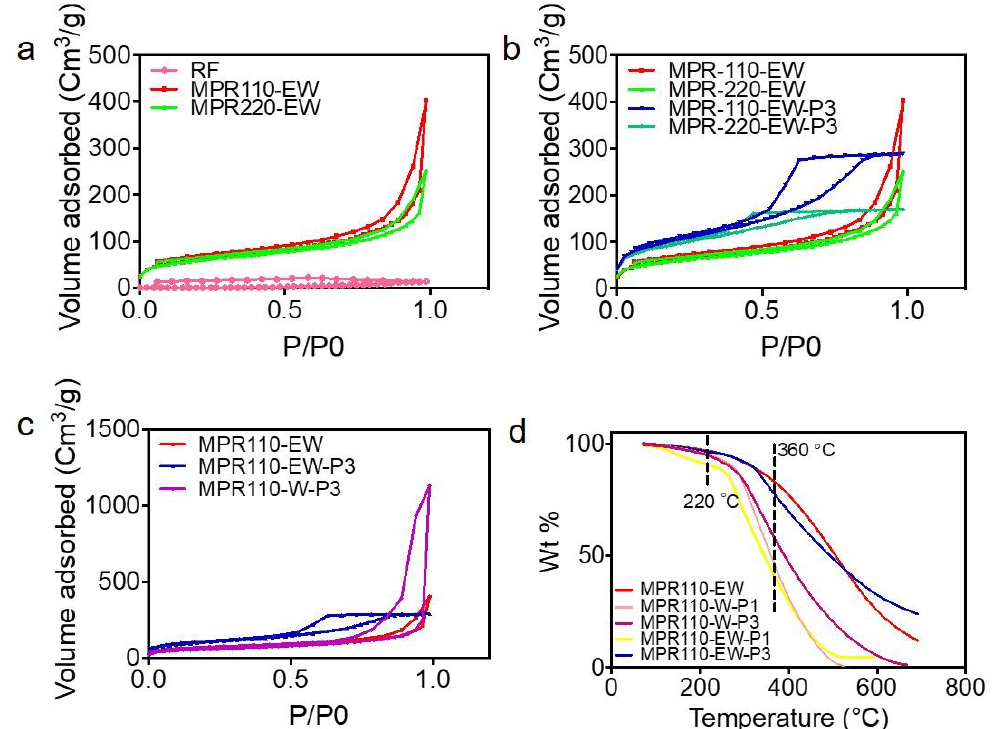
Figure 1. ( a – c ) N 2 adsorption − desorption isotherms of ( a ) MPR with varying PEI concentration, ( b ) Pd-MPRs with varying Pd concentrations, and ( c ) Pd-MPRs made either in the presence of water or water / ethanol as the solvent. ( d ) Thermal stability of MPR with varying PEI concentration (RF = nonporous resorcinol-formaldehyde resin; 110 and 220 = 110 mg and 220 mg PEI, respectively; EW = ethanol-water; W = water solvent; P1 and P3 = 1 wt % Pd and 3 wt % PD, respectively).